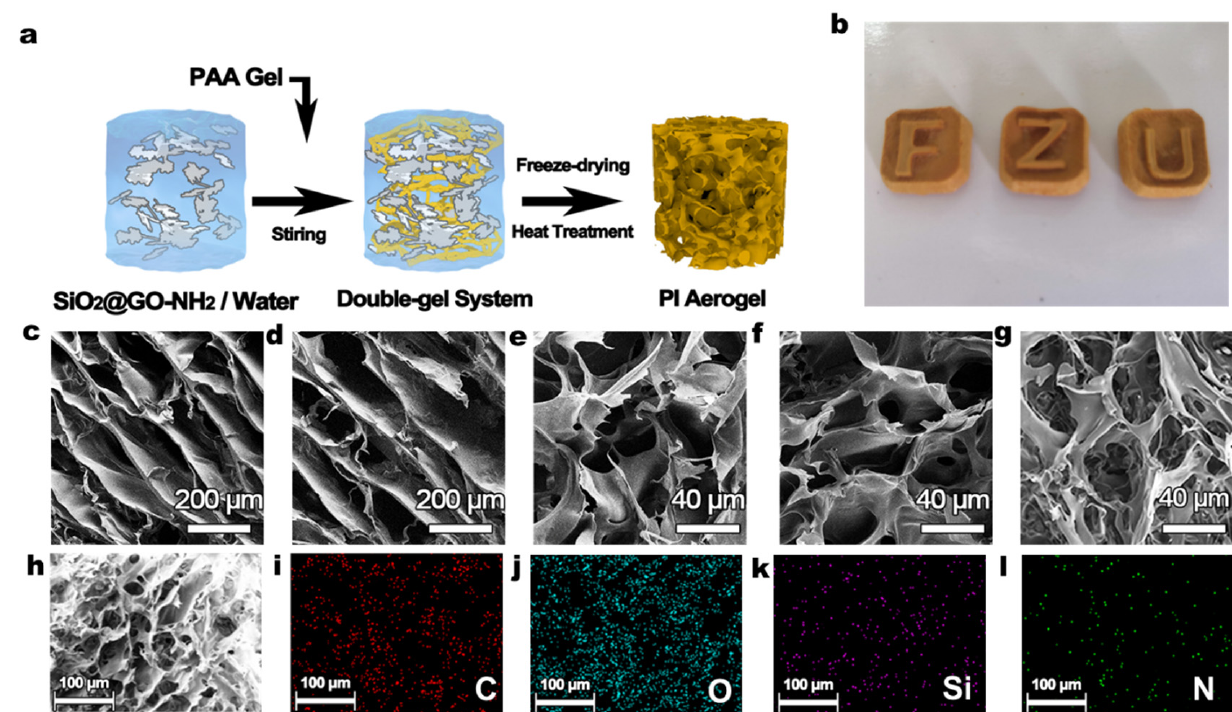
Figure 2. ( a ) Preparation process of double-gel PI aerogel. ( b ) A set of PI aerogels was prepared using custom molds, demonstrating the scalability of the preparation process. ( c – g ) SEM images of PI-0, PI-0.5, PI-1, PI-1.5, and PI-2. ( h ) Another SEM image and ( i – l ) EDS maps of PI-1.5 in the same area.